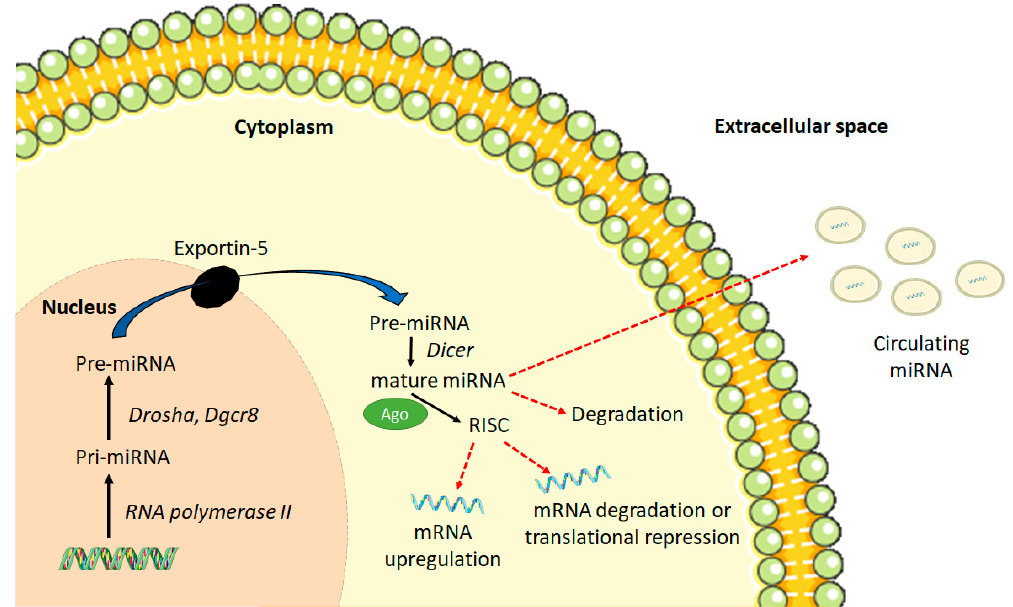
Figure 1. Schematic of miRNA biogenesis and function. AGO, Argonaute protein; RISC, RNA-induced silencing complex.